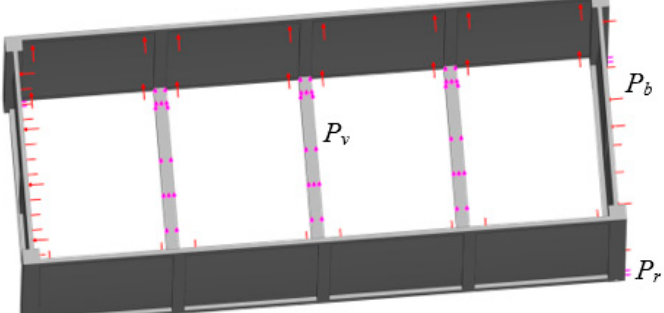
Figure 9. Design diagram of a container.